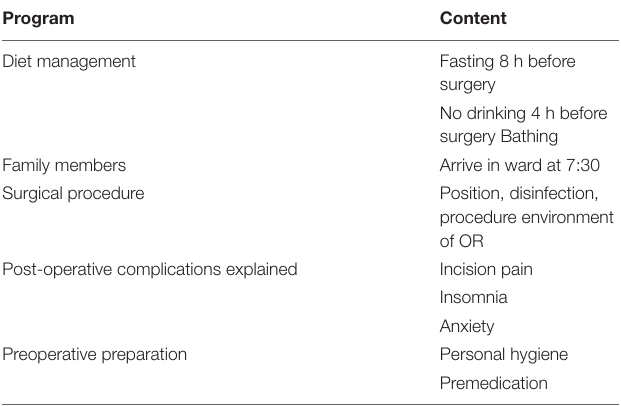
TABLE 4 | Preoperative health education program.